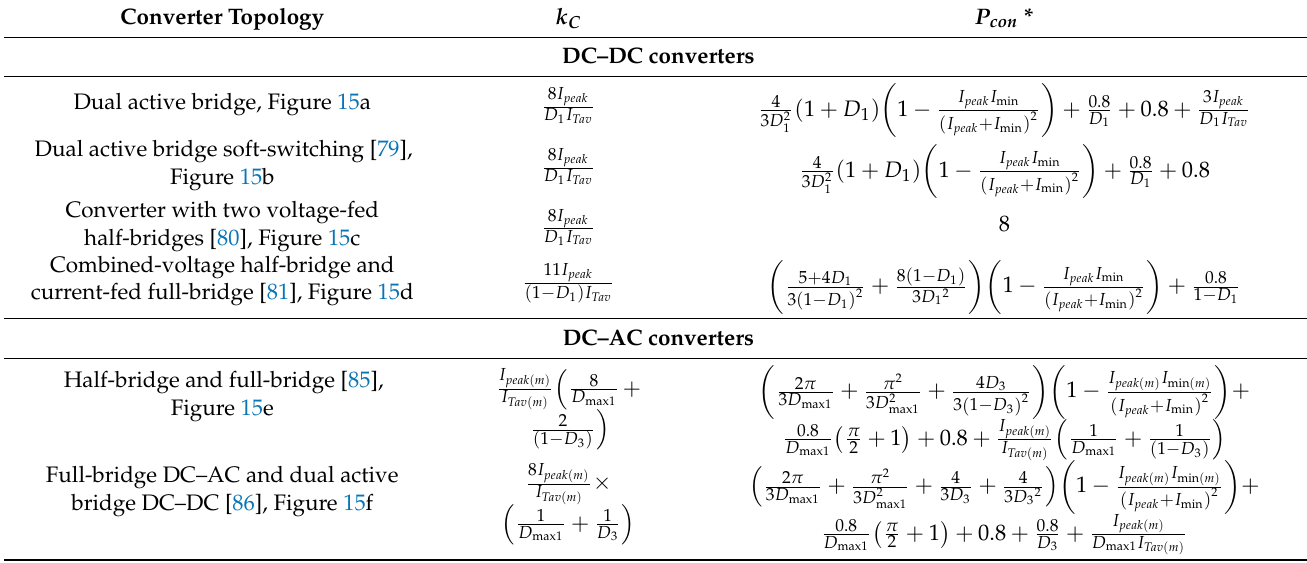
Table 7. A Comparative analysis of the two-stage energy storage converters’